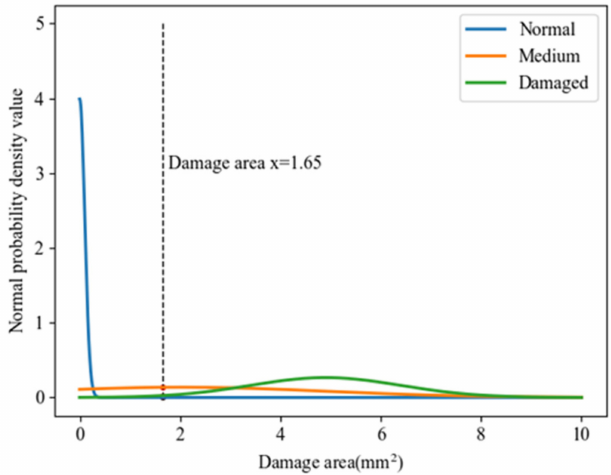
Figure 11. Distribution diagram of normal function of three